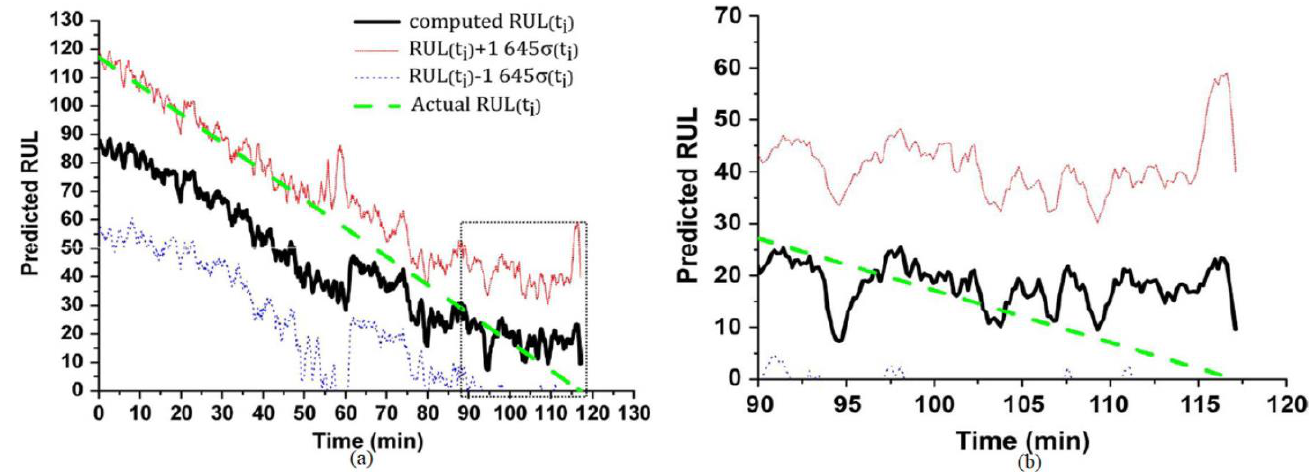
Figure 54. ( a ) Prognosis result for prediction of RUL. ( b ) Zoom view